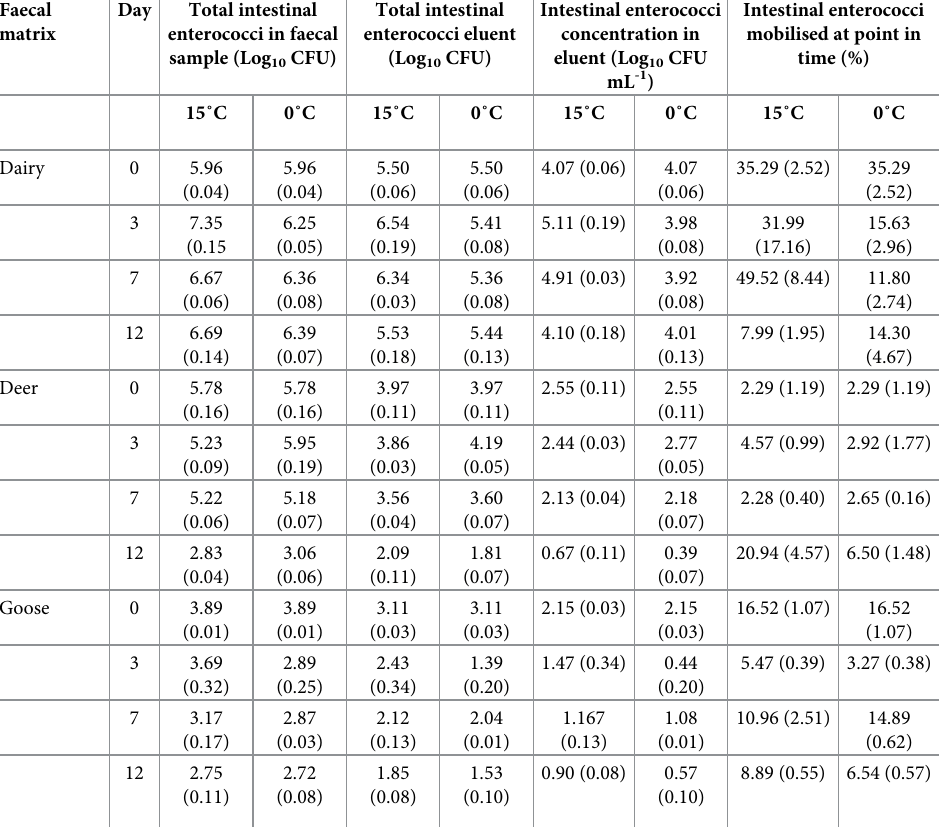
Table 2. Total number of intestinal enterococci CFU in faecal and eluent samples, associated intestinal entero- cocci concentrations in eluent samples and percentage of cells mobilised for each time-point. Data are the mean of five replicates ( ± standard